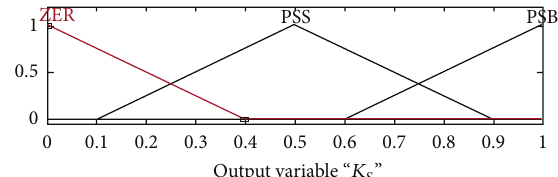
Figure 12: Membership function of fuzzy logic controller for output pole-placement gain ( 𝐹𝐾 𝑆 ).